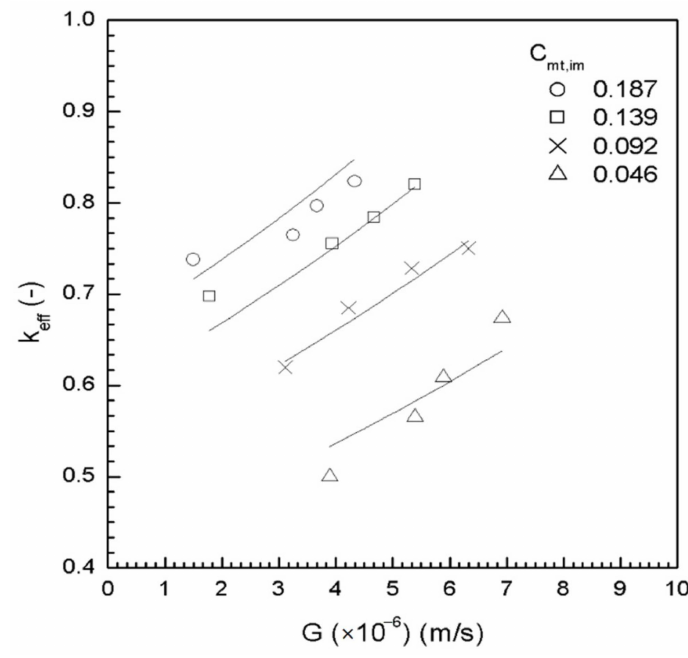
Figure 5. The dependence of k eff on G for various C mt,im